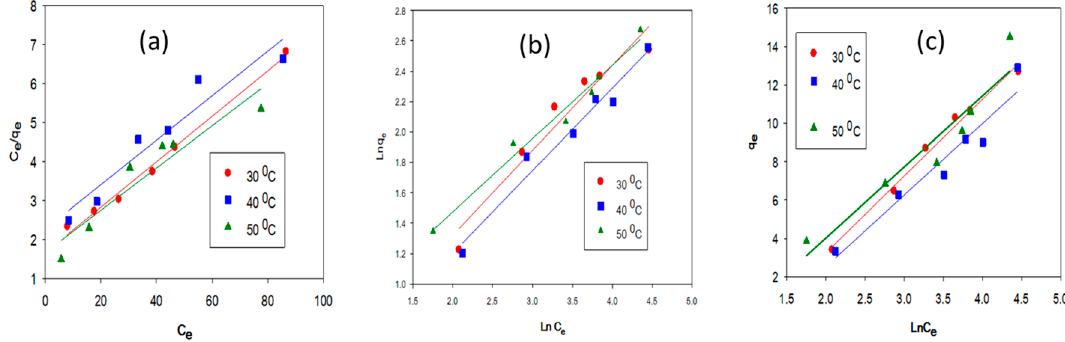
Figure 8. Linear Regression Analysis of ( a ) Langmuir, ( b ) Freundlich, and ( c ) Temkin Isotherm model at different temperatures for LFP-300.